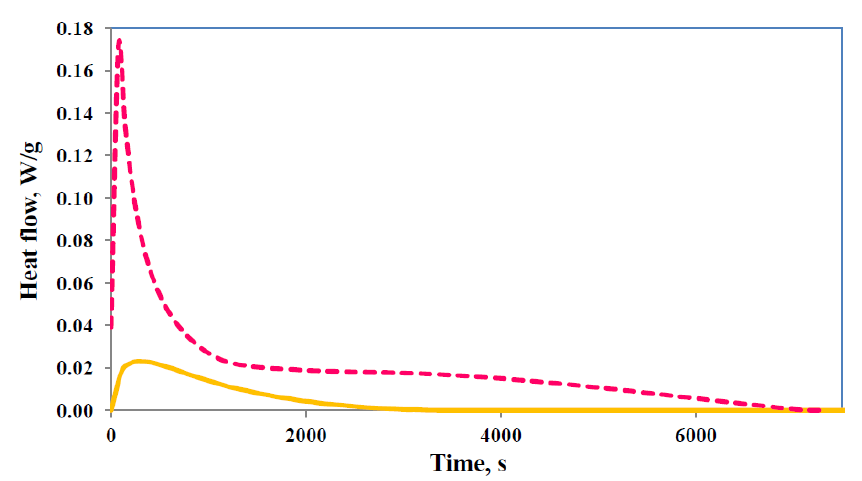
Figure 5. DSC scans for the isothermal cure of TGAP/DDS/MMT (5 wt%) with 1 wt% initiator (BF ·MEA) at different temperatures: 100 °C (orange, full line) and 120 °C (pink, 3 dashed line). Exothermic direction is